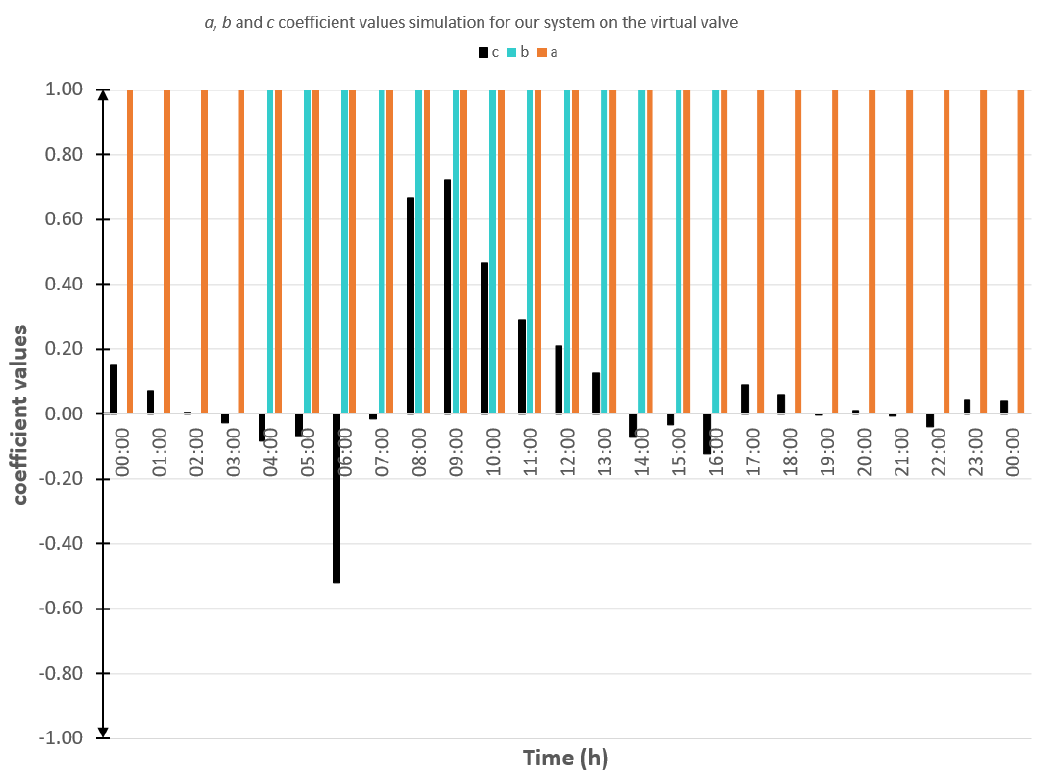
Figure 13. The a , b , c coefficient values simulation for our system on the virtual valve. In our simulation, all energy from the biogas plant and photovoltaic installation is used in the system once produced, therefore the a and b coefficients are 1 or 0 in given instances. Coefficient c changes over time and takes values from a = [ − 1; 1] range, as stated before. This set of coefficients can be adjusted over time using, e.g., artificial intelligence or prediction and optimization based on profiles of usage over time for specified farm- lands and the number and types of recipients. However, it is now visible that these coef- ficients can manage the smart valve’s operation, rendering the proposed system inde- pendent from the power grid and keeping it self-sufficient in terms of energy production and consumption. We can also notice that if we observe 2 days (48 h) as the simulation interval using the same input data, the coefficient c becomes stabilized, and the daily cycle repeats its profile (Figure 14). It is to be further investigated how to optimize the system and apply or adjust prediction algorithms to achieve a better match to the loads’ profile and the en- ergy storage unit’s capacity.